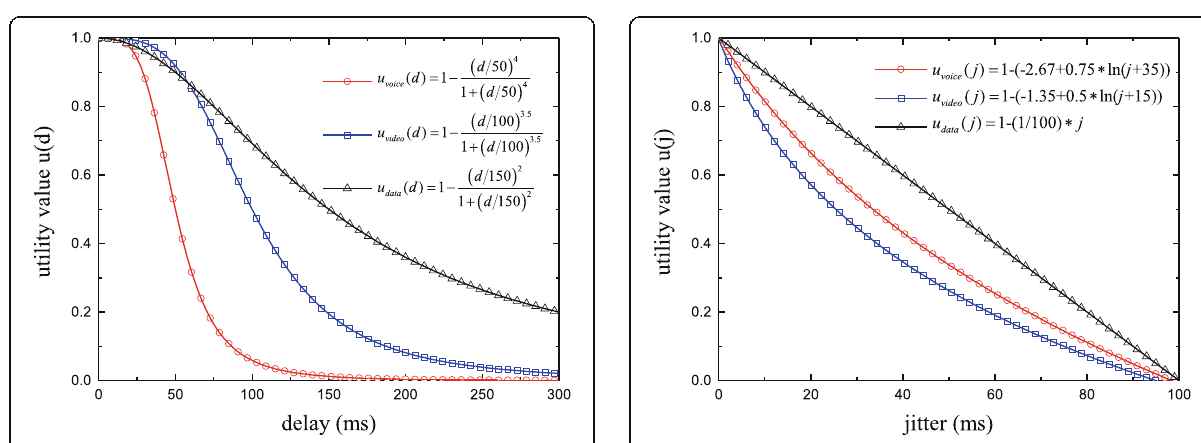
Fig. 5 Delay utility function curve for voice, video, and data applications